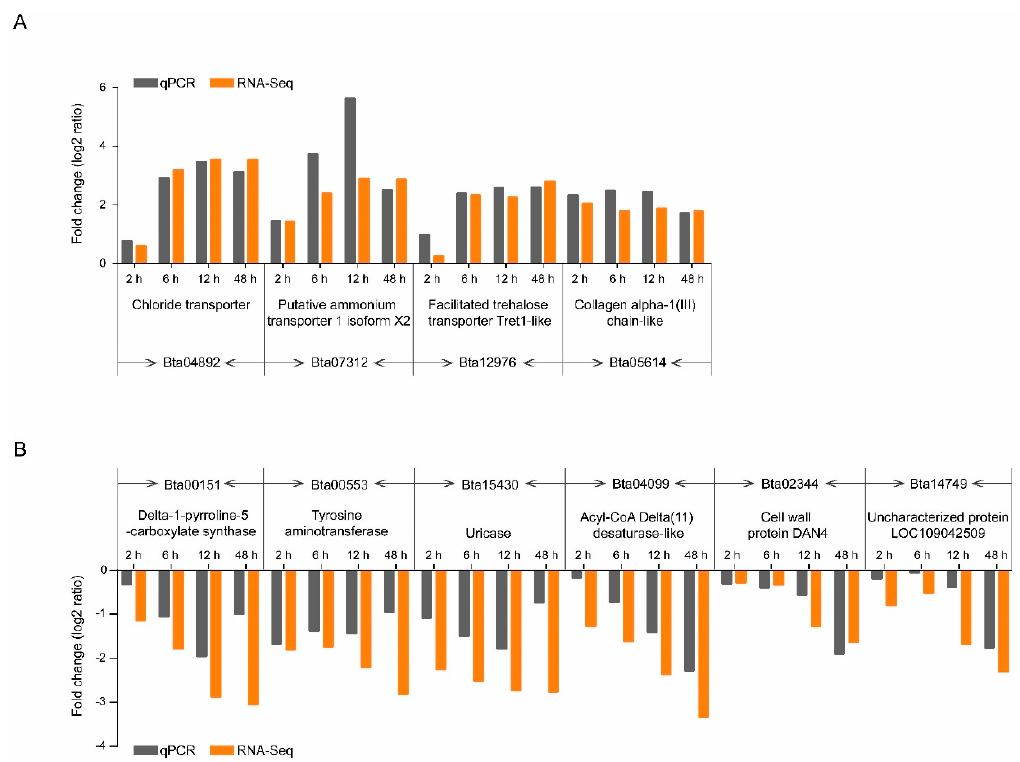
Figure 6. Expression patterns generated by the results of RNA-seq and RT-qPCR analyses. Four up-regulated and six down-regulated DEGs identified by RNA-seq were validated by comparative CT ( Δ CT) RT-qPCR with β -actin as the